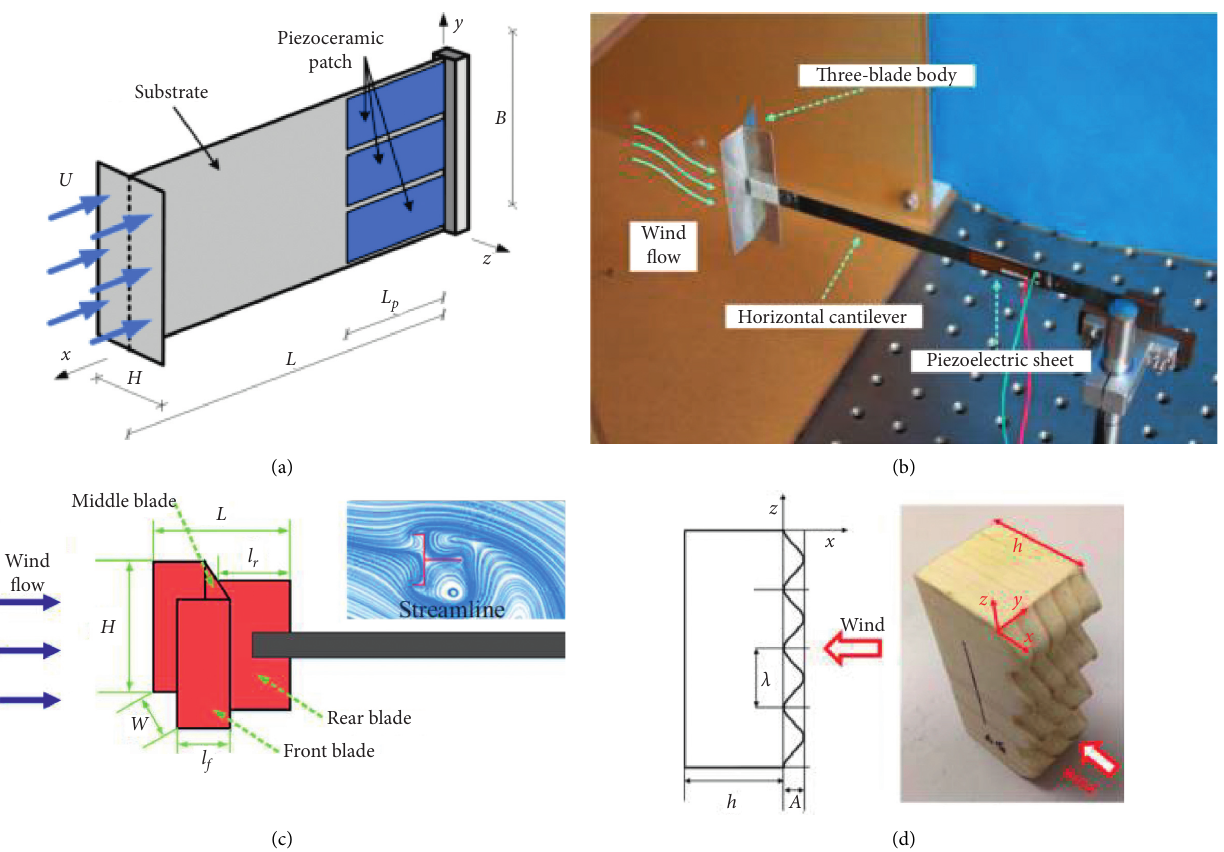
Figure 8: Bluff body with different cross-sections. (a) T-shape [81]. (b) Y -shape [82]. (c) Fork-shape [83]. (d) Bioinspired shape